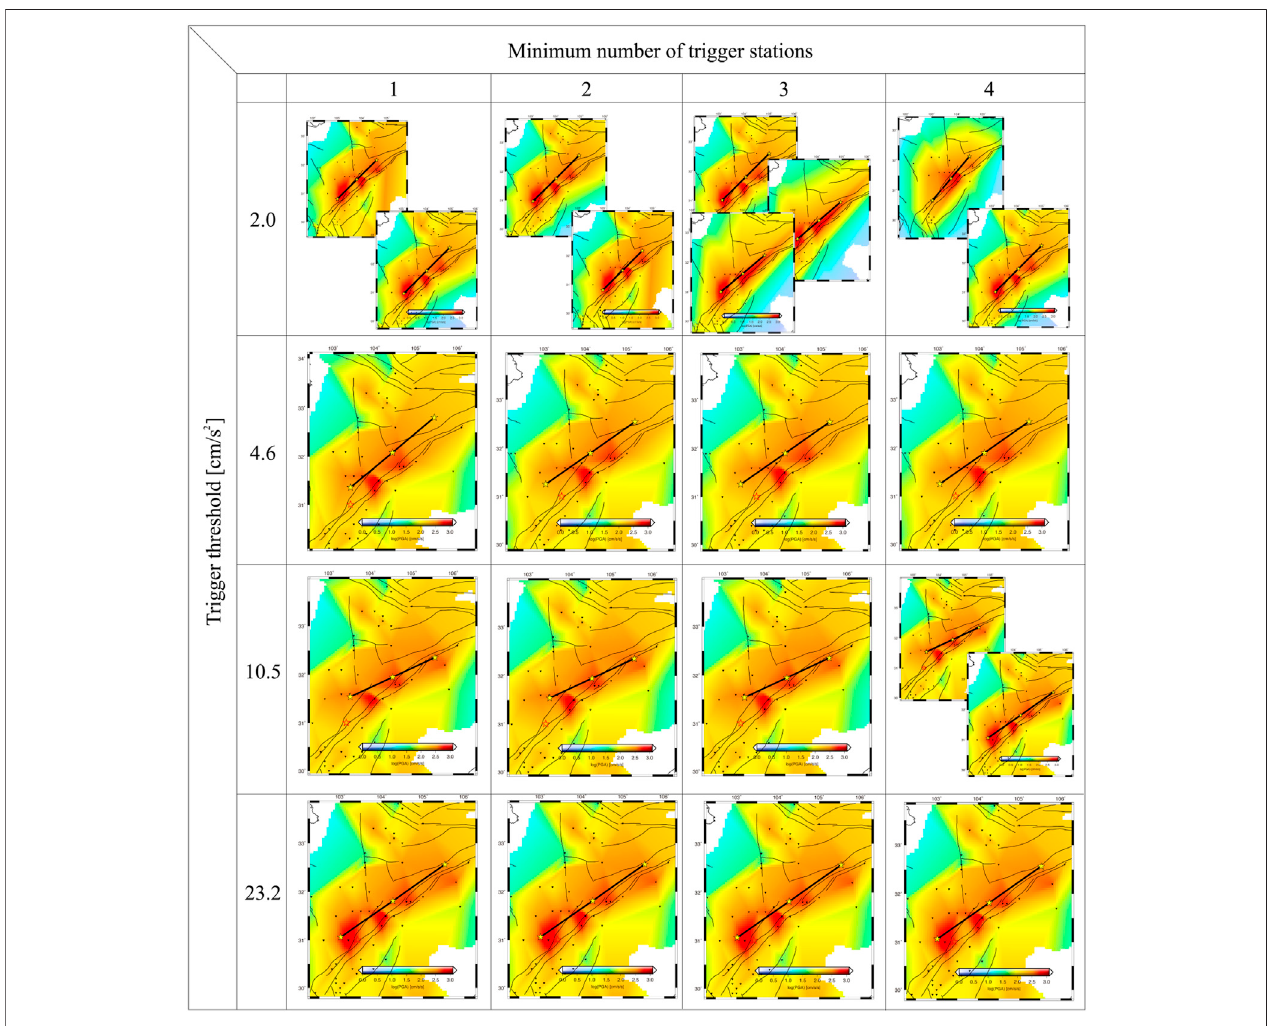
FIGURE6| TestingFinDertriggerparametersfordifferentPGAthresholds(toptobottom:2.0,4.6,10.5,and23.2 cm/s 2 )andminimumnumbersofstations(leftto right:1 – 4),atwhichthisthresholdneedstobeexceeded,usingthe2008 M S 8.0Wenchuanearthquake.Themapsshowthe fi nalFinDerline-sourcemodels(blacklines) fortherespectivetriggercon fi guration.Ingeneral,thetriggerparametersdependonthedensityandnoiseconditionsofthenetworkinwhichFinDerisapplied.Forsome con fi gurations,e.g.foratriggerthresholdof2 cm/s 2 ,FinDercreatesmultiplesolutions(splitevents).Asacompromisebetweenaccuracyandtimelinessoftheline- source models, we chose in this study a trigger threshold of 4.6 cm/s 2 and a minimum number of three stations.